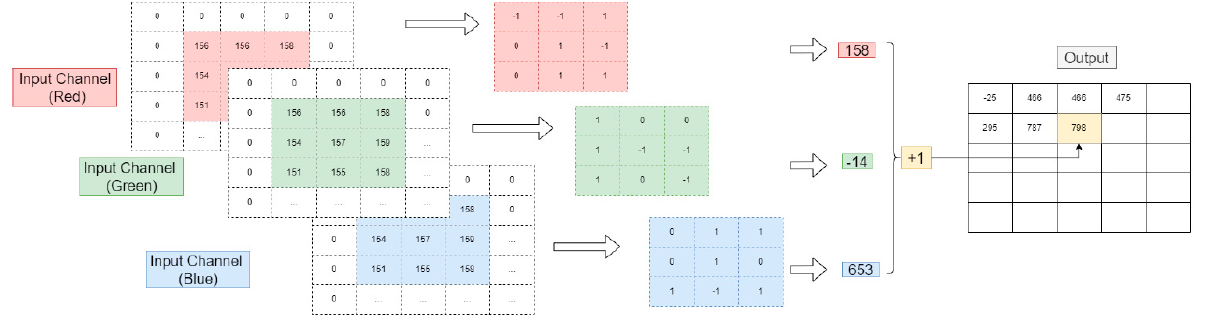
Figure 3. The application of convolution layer on RGB image.